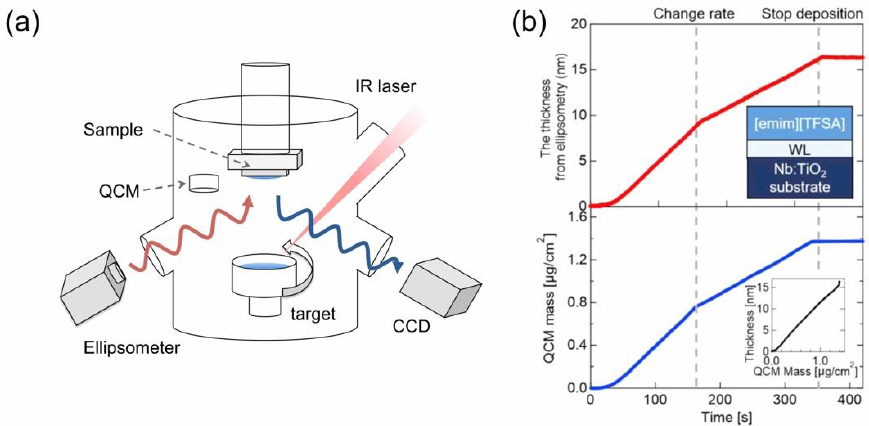
Figure 1. ( a ) Schematic of an IR laser deposition system equipped with an ellipsometry for thickness monitoring. ( b ) Time-development of the IL [emim][TFSA] film thickness estimated by ellipsometry and the QCM mass signal, both of which values are linearly well correlated. Reproduced with permission from ref. [19]. Copyright 2020, IOP Publishing Ltd.